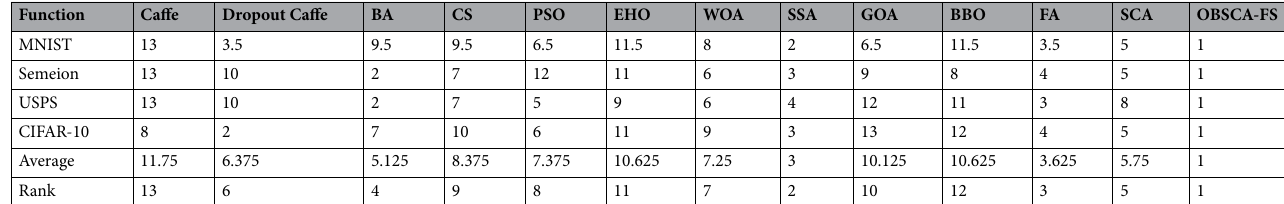
Table 10. Friedman ranks for the comparable method over 4 CNN classification